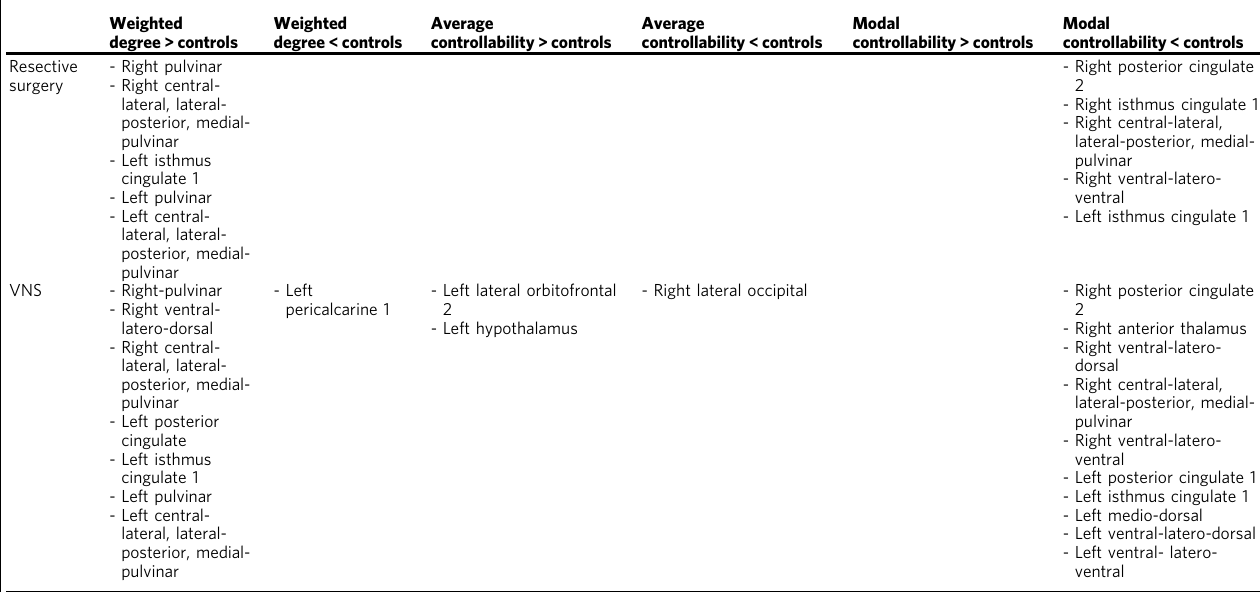
Table 1 Identi fi ed parcels that had a signi fi cantly different weighted degree, average controllability and modal controllability in both groups of patients compared to healthy